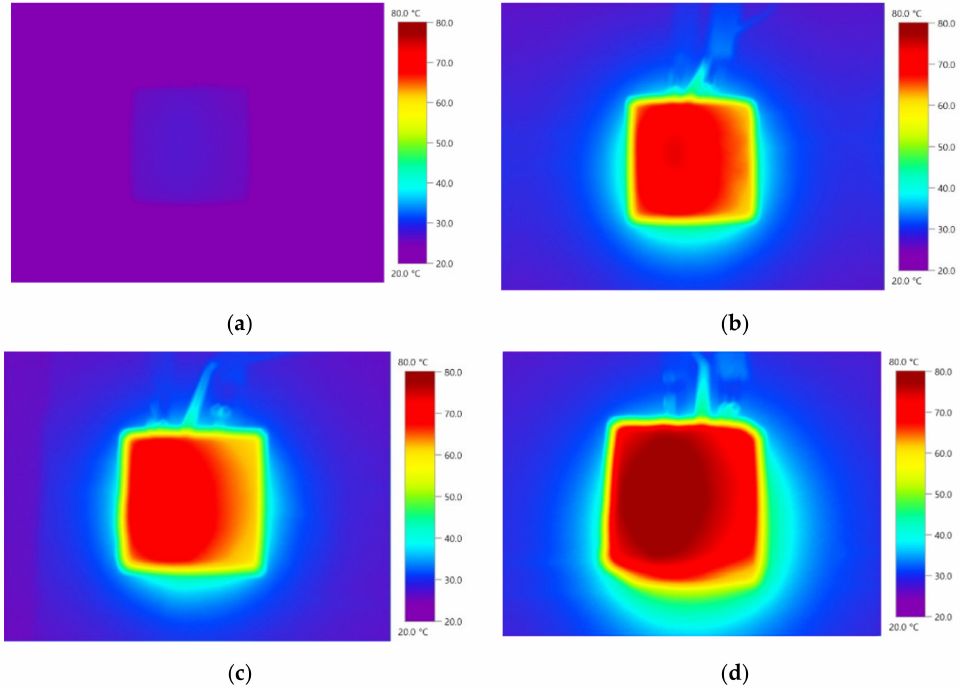
Figure 8. Thermal images of the nanocementitious composites with 1.0 wt% (60 V): ( a ) OPC; ( b ) GNP-